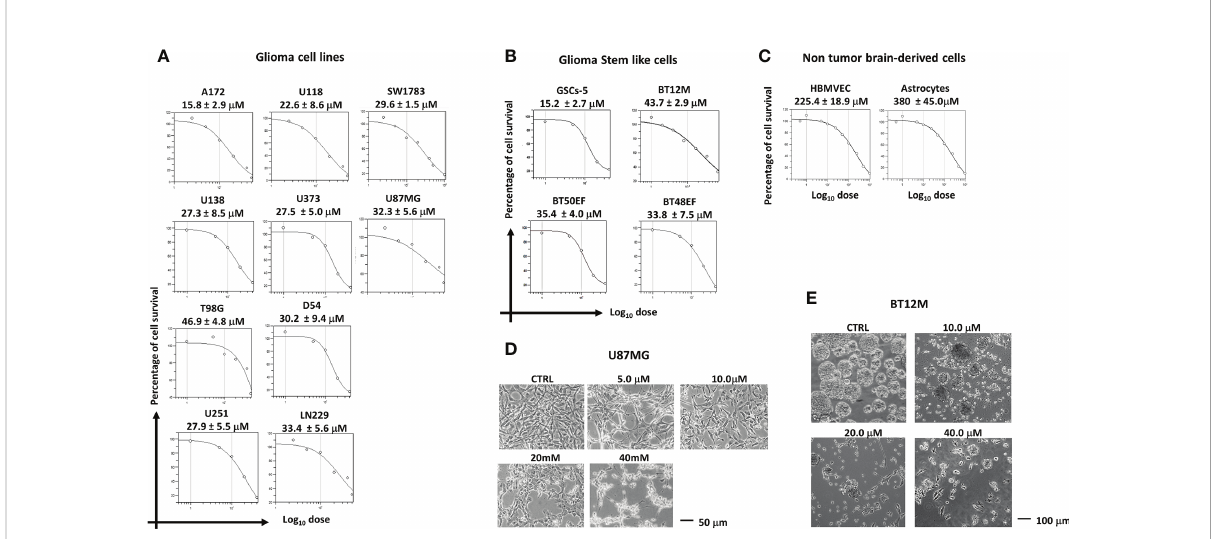
FIGURE 1 ABTL0812 inhibits proliferation of glioblastoma cells and glioblastoma stem cells. (A) ABTL0812 cell proliferation curves and IC 50 s at 48 hours in glioblastoma cell lines, (B) at 96 hours in patient-derived glioblastoma stem cells (GSCs) and (C) at 48 hours in HBMVEC and astrocytes. (D) Images of U87MG cells treated for 48 hours with ABTL0812 showing that ABTL0812 induce cell extensions associated to type I astrocytic phenotype and cell death and detachment. Bar represents 50 µm (E) Neurosphere formation in BT12M cells treated for 96 hours with different concentrations of